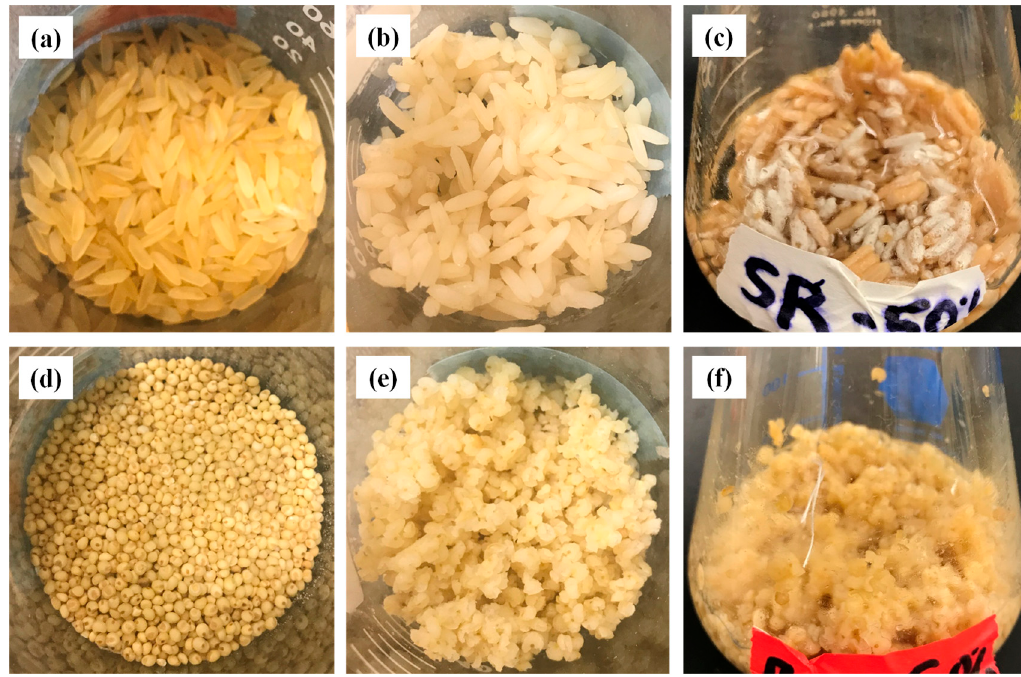
Figure 1 . Photos of ( a ) raw and ( b ) autoclaved parboiled rice, ( c ) Bacillus pumilus grown on parboiled rice at 50% moisture content, ( d ) raw and ( e ) autoclaved millet, ( f ) Streptomyces griseus grown on millet at 50% moisture content.